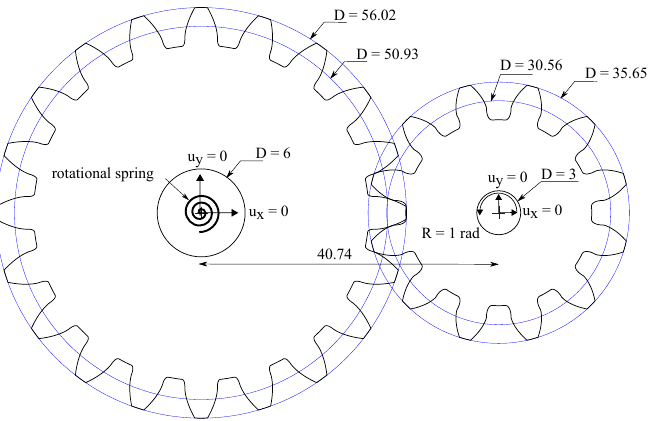
Figure 8. Cracking in interacting gears: geometry, dimensions (in mm) and boundary